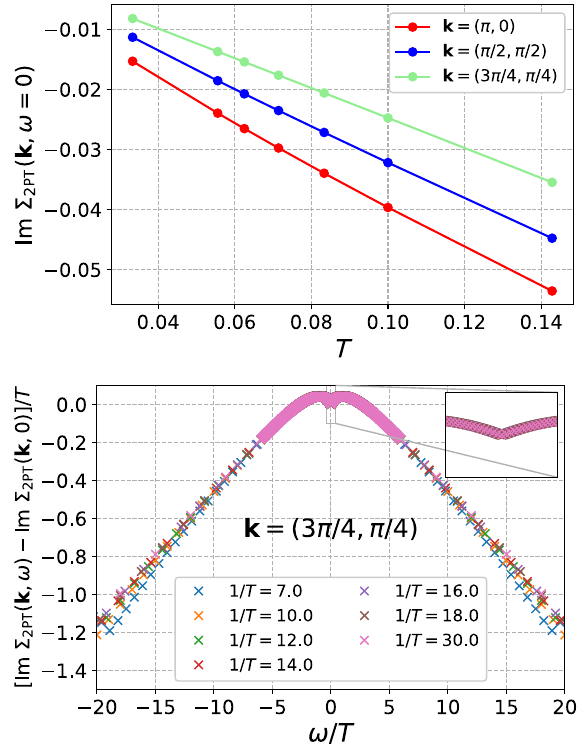
FIG. 30. Upper panel: imaginary part of the self-energy on the real axis at zero frequency and various Fermi-surface points calculated in second-order perturbation theory as a function of temperature. Lower panel: data collapse from ω =T scaling at the generic momentum point for several temperatures in the metallic regime. The inset shows a zoom to low